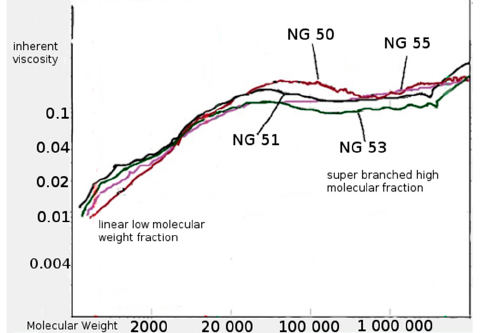
Figure 5. Relationship between the inherent viscosity and molecular weight of obtained poly( L -lactide)– co –poly(butylene citrate).